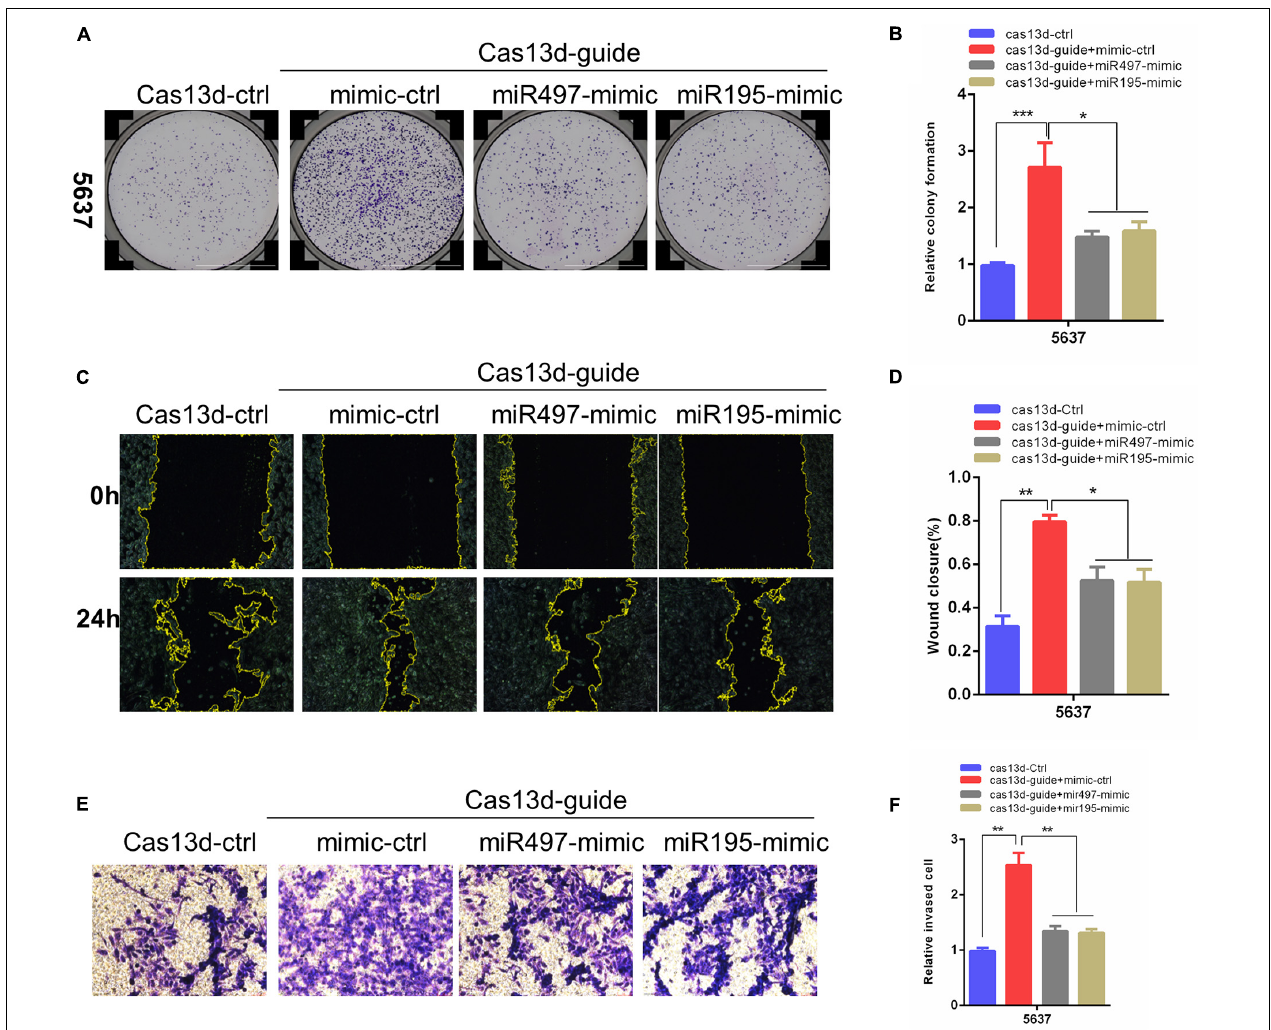
FIGURE 3 | MiR-497 and miR-195 rescued the enhancing effects of MIR497HG inhibition via CRISPR/Cas13d on BCa progression. (A, B) Clonogenic assay showed that miR-497 or miR-195 mimics reversed partial Cas13d-mediated silenced MIR497HG enhancing growth of BCa cell. Wound healing assays (C, D) and Transwell assays (E, F) indicated that miR-497 or miR-195 mimics rescued the enhancing function of Cas13d-mediated MIR497HG knockdown on migratory and invasive activity of 5637 cells. Data are shown as mean ± SD. n = 3 for technical replicates. * P < 0.05, ** P < 0.01, and *** P < 0.001. P values are calculated by Student t